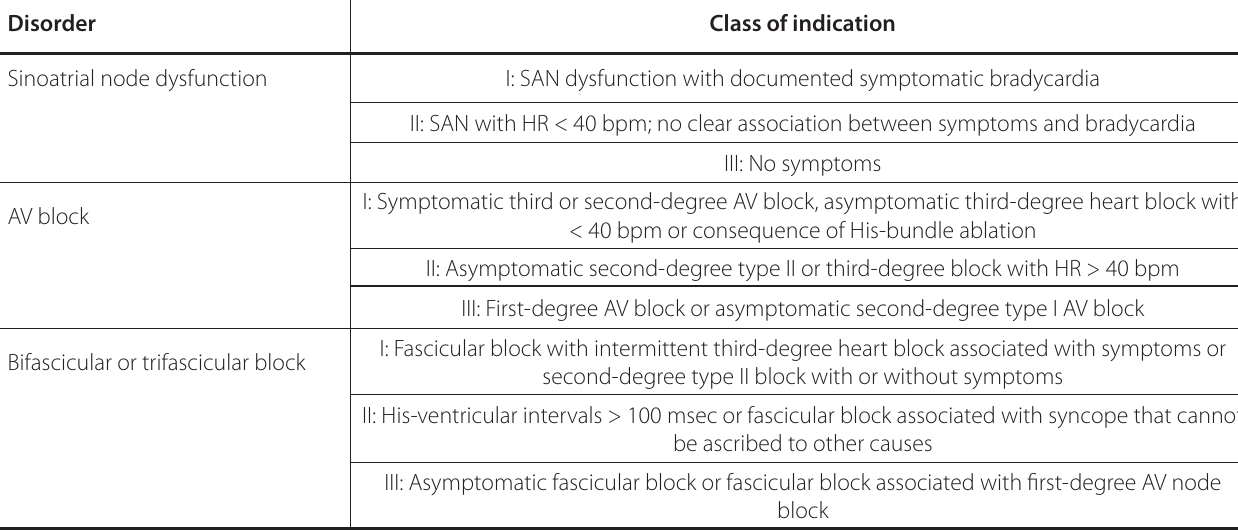
*According to classification system established by the Joint American College of Cardiology-American Heart Association Task Force. AV=atrioventricular; bpm=beats per minute; HR=heart rate; PPM=permanent pacemaker; SAN=sinoatrial